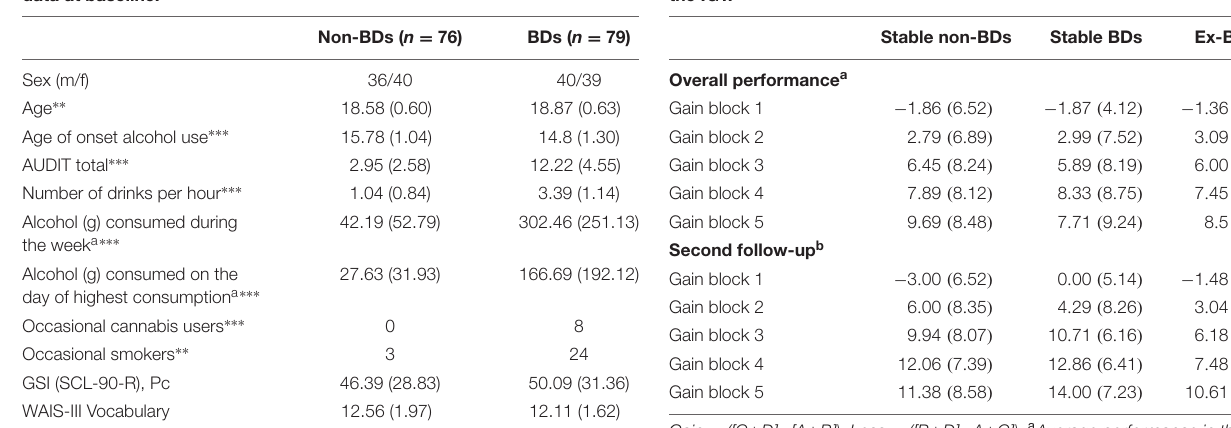
TABLE 3 | Means (and standard deviations) for gain in each block of the IGT.